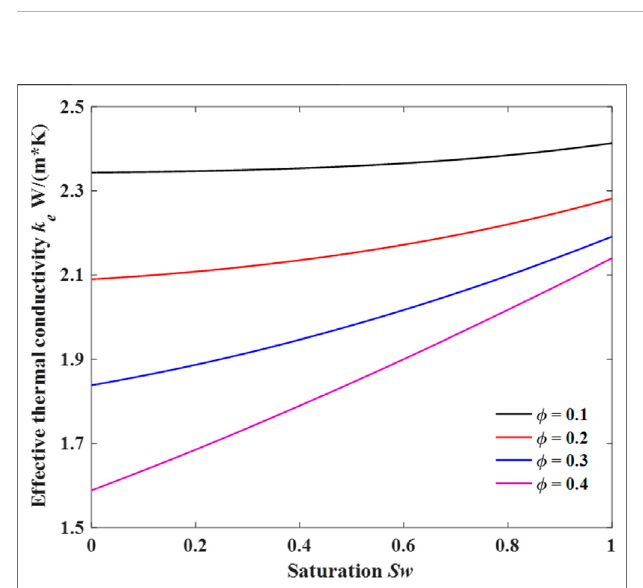
FIGURE 7 | The effect of capillary fractal dimension on the